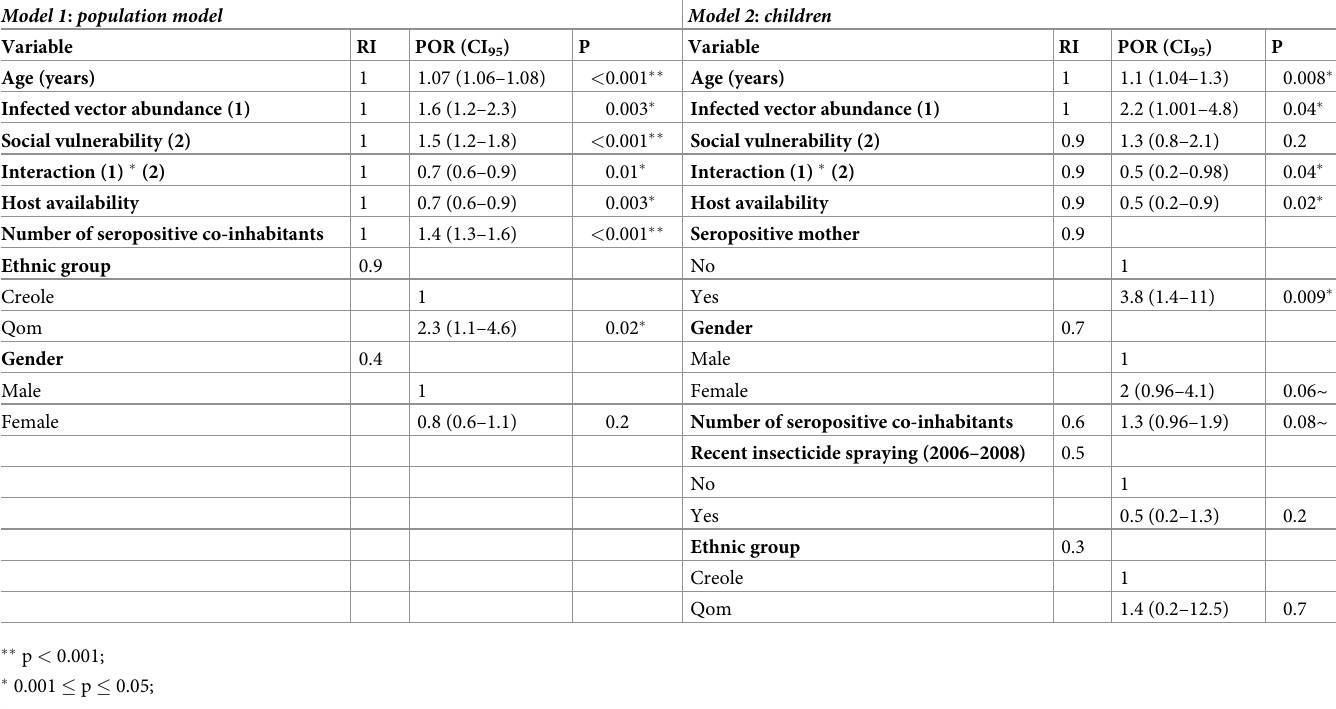
Table 2. Generalized linear model (logit link function) of human seropositivity for T . cruzi infection for the total population (model 1) and children (model 2), Pampa del Indio, Argentina. Model 1 : population